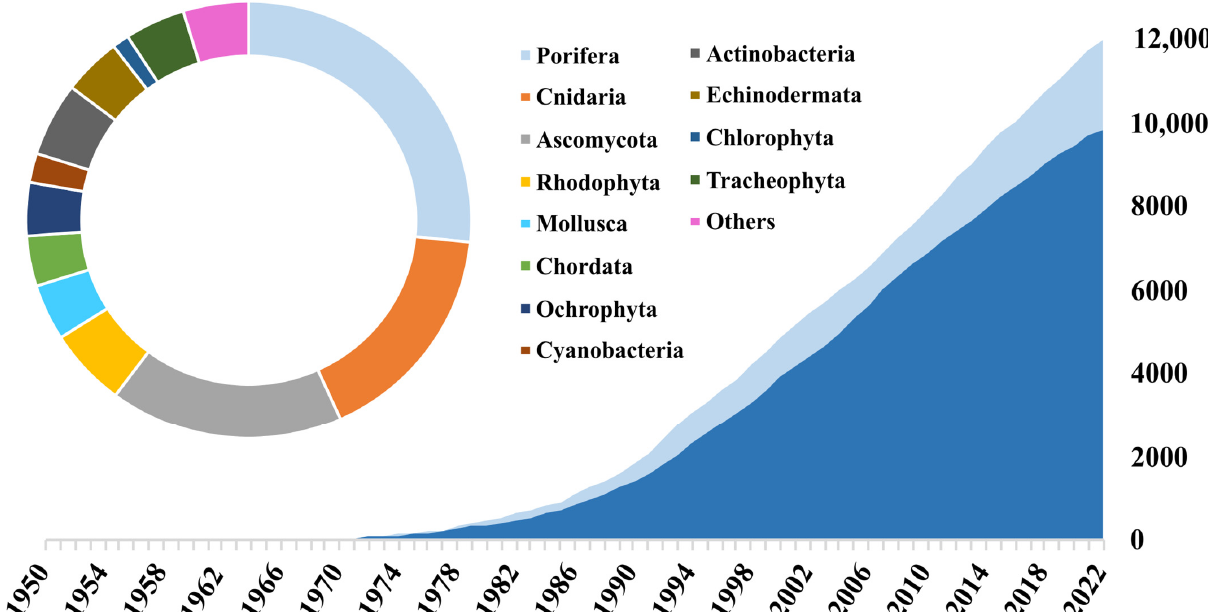
Figure 2. Cumulative number of compound discoveries (light) and publications (dark) on marine sponges over the last seven decades. The proportion of marine natural products of poriferan origin regarding the total number of described molecules is shown in the pie chart. Row data from https://marinlit.rsc.org (accessed on 14 November 2022).